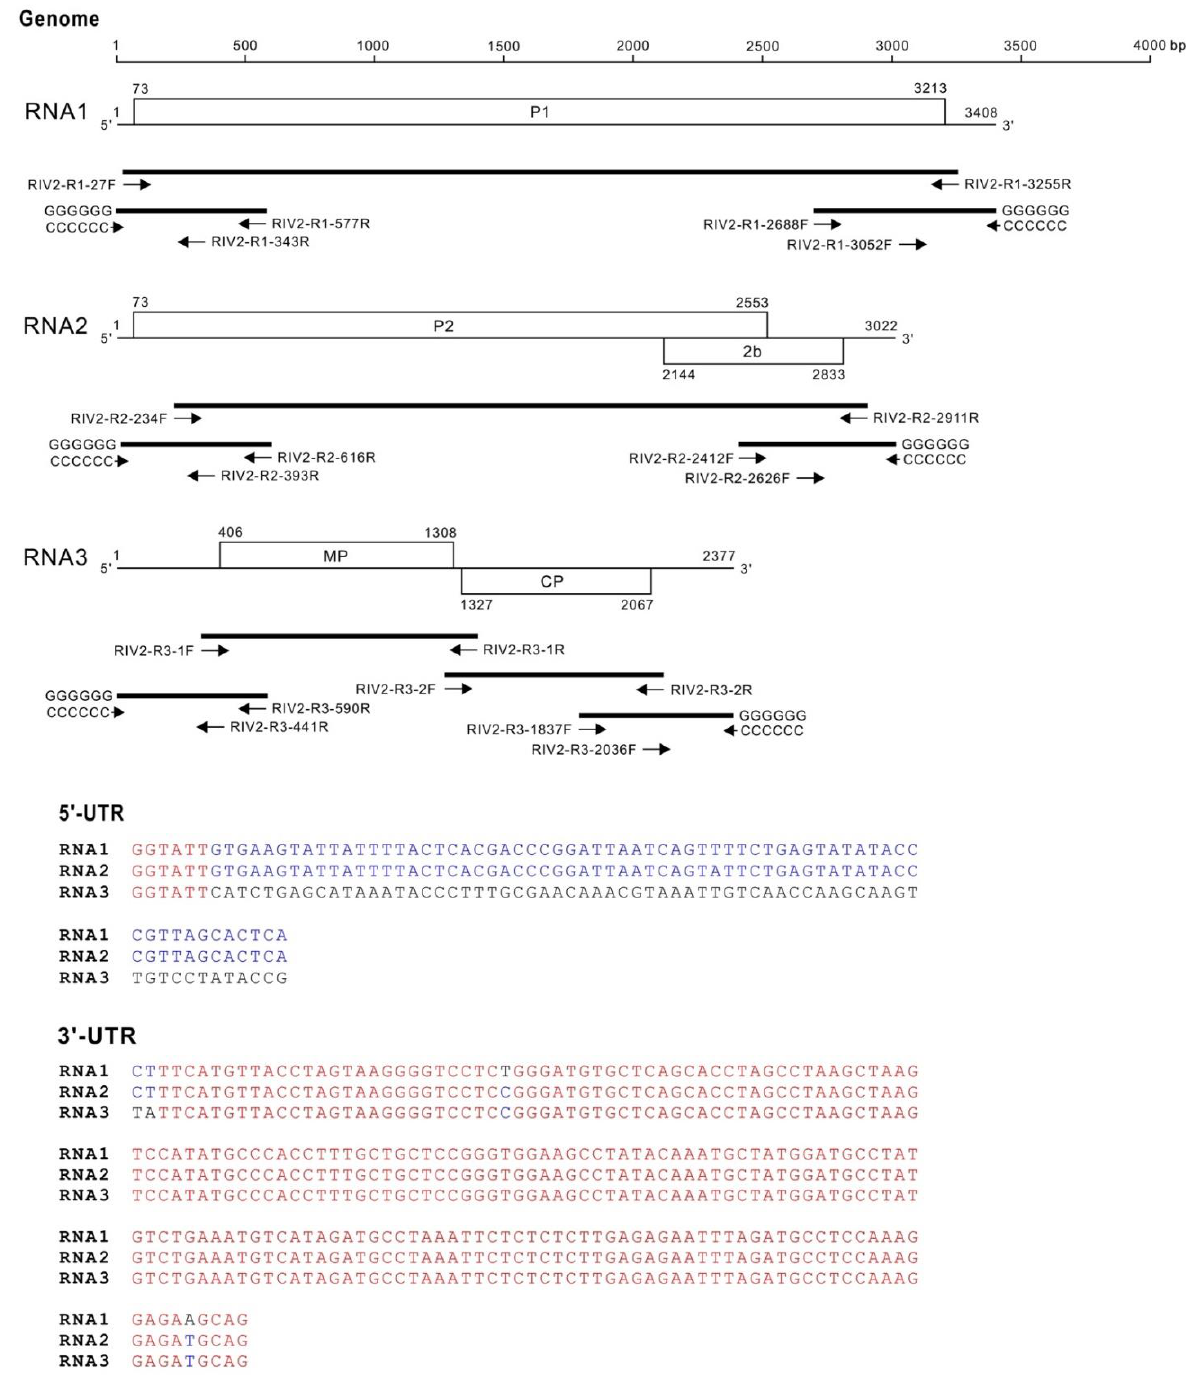
Figure 3. Schematic representation of genome organization of rose ilarvirus 2 (RIV-2). White boxes represent open reading frames (ORFs). Lines represent untranslatable regions (UTRs). The nucleotide positions of the individual ORFs are indicated. Bold lines represent DNA fragments amplified by reverse transcription-polymerase chain reaction (RT-PCR). Primers used for RT-PCR amplification are indicated by arrows. The nucleotide sequences of the primers are shown in Table S2. Nucleotide sequences of the 5 (cid:48) -untranslatable region (UTR) and 3 (cid:48) -UTR are shown below. Identical nucleotides in the three genomic RNA segments are indicated in red. Nucleotides that are identical in two of the three genomic RNA segments are indicated in